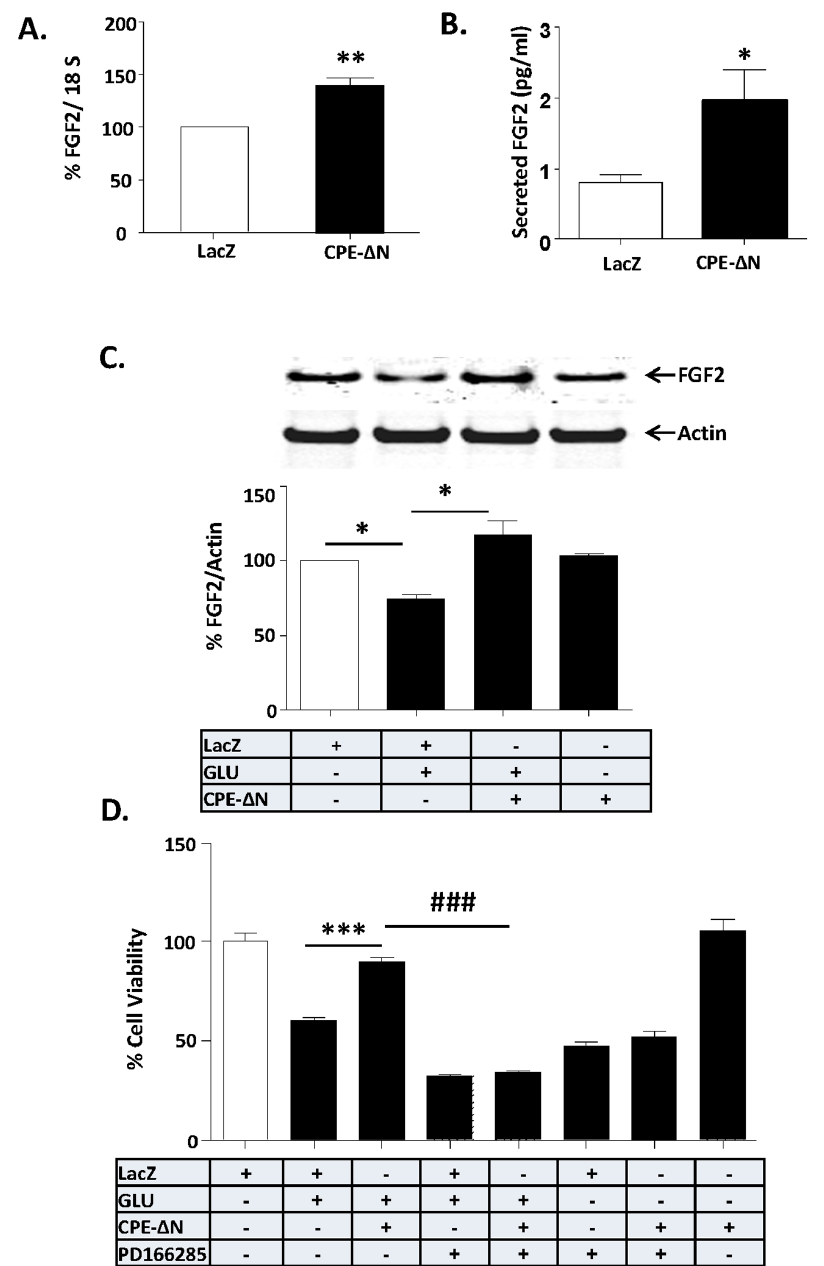
Figure 4. Neuroprotection by CPE- D N is mediated by FGF2. A. Bar graph shows the quantification by qRT- PCR of FGF2 mRNA in primary cultured rat cortical neurons after transduction with CPE- D N or LacZ (control) viral vectors. Data are normalized against 18S RNA and presented as a % compared to control (LacZ) cells. Values are the mean ¡ SEM (n 5 5), t test, ** p , 0.01. At least three independent experiments were done. Data shown represent all the experiments combined. B. Bar graph shows the levels of secreted FGF2 by ELISA in primary cultured rat cortical neurons after transduction with CPE- D N or LacZ (control) viral vectors. Values are the mean ¡ SEM (n 5 4), t test, * p , 0.05. Two independent experiments were done. Data shown represent one experiment. C. Top panel: Western blot analysis of FGF2 protein in primary cortical neurons, transduced with CPE- D N or LacZ viral vectors and subsequently challenged with or without glutamate for 24 h. Actin was also analyzed and served as an internal control for protein load; Bottom panel: Bar graphs show the quantification of FGF2 protein normalized to actin and expressed as a % compared to